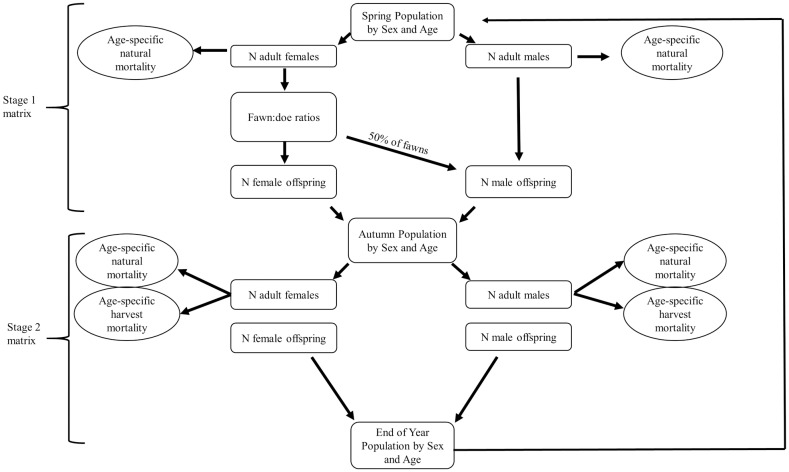
Schematic representing the white-tailed deer life cycle used in the parameter validation model.